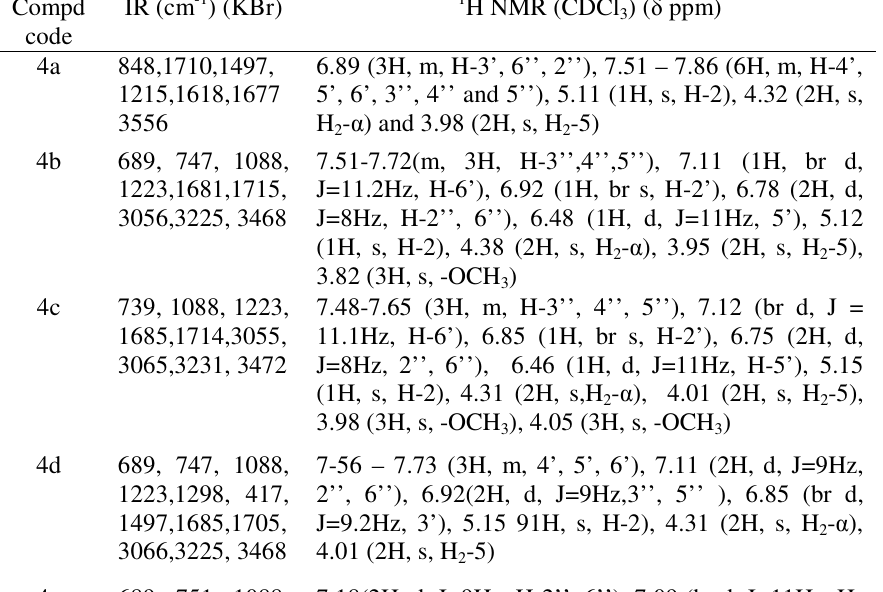
Table-2 . IR, 1 H NMR Spectral data of the compounds (4 Compd